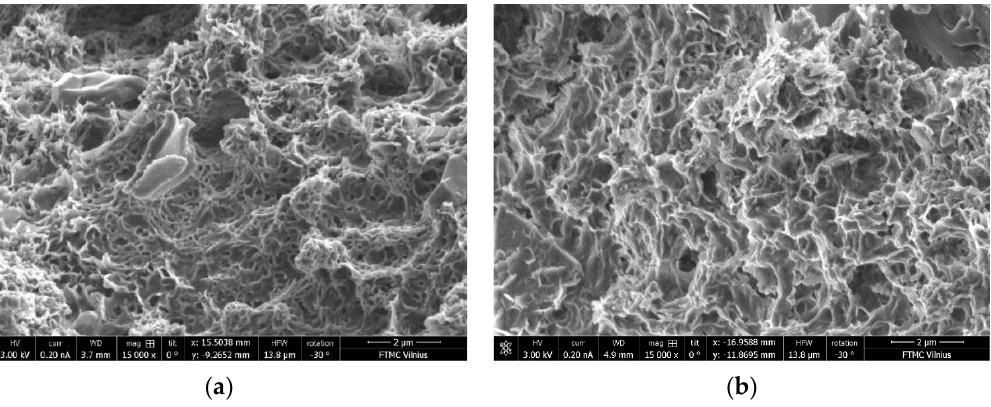
Figure 19. Microstructure of the samples cured at 20 °C: ( a ) CS-0.40-20; ( b ) CS-1.20-20 (magnification 15,000).